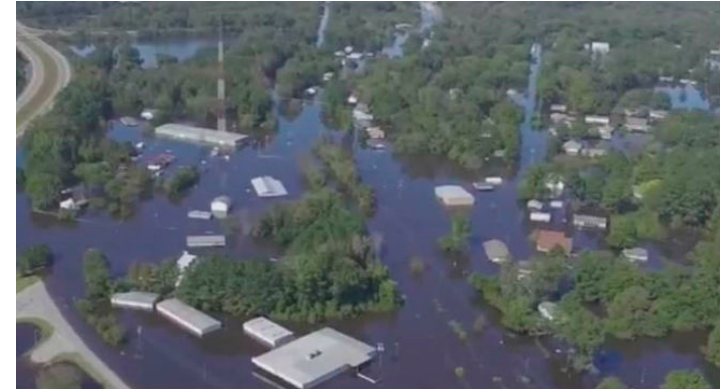
Figure 1. Study area: Princeville (North Carolina, USA) during Hurricane Matthew. Seven photo-controlled points were surveyed, but only four of them were visible in sufficient redundant photographs to be used for georeferencing the UAV images. The photo-controlled points had a vertical accuracy of 4 cm and a horizontal accuracy of 2.3 cm.